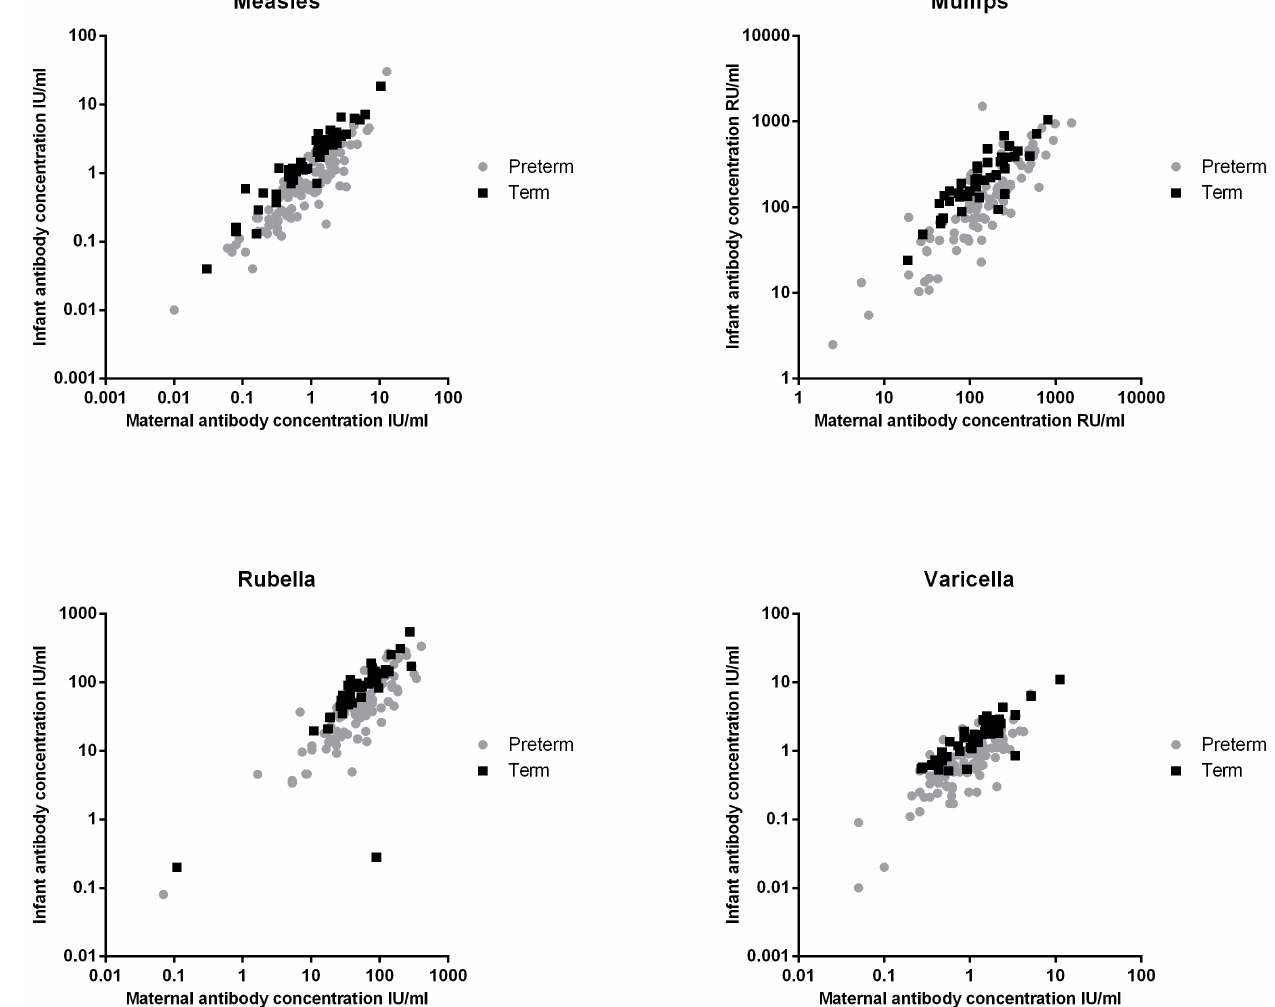
Figure 2. Individual maternal-to cord blood antibody concentrations of measles (IU/ml), mumps (RU/ml), rubella (IU/ml) and varicella (IU/ml).